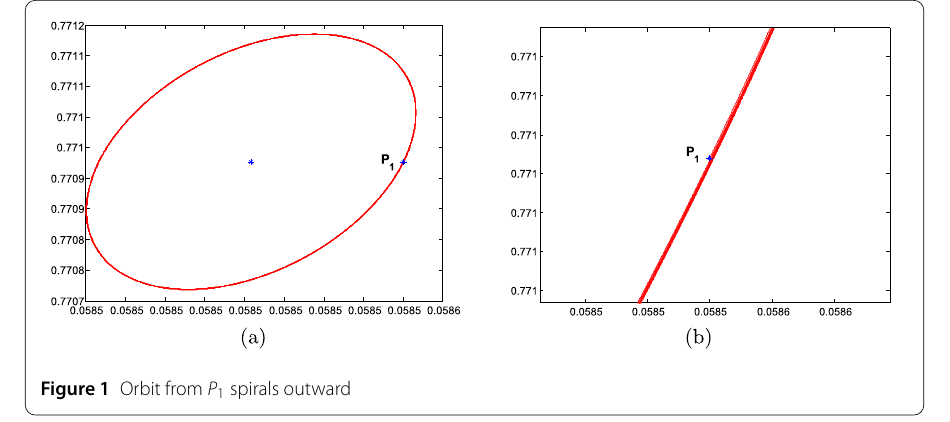
Figure 1 Orbit from P 1 spirals outward